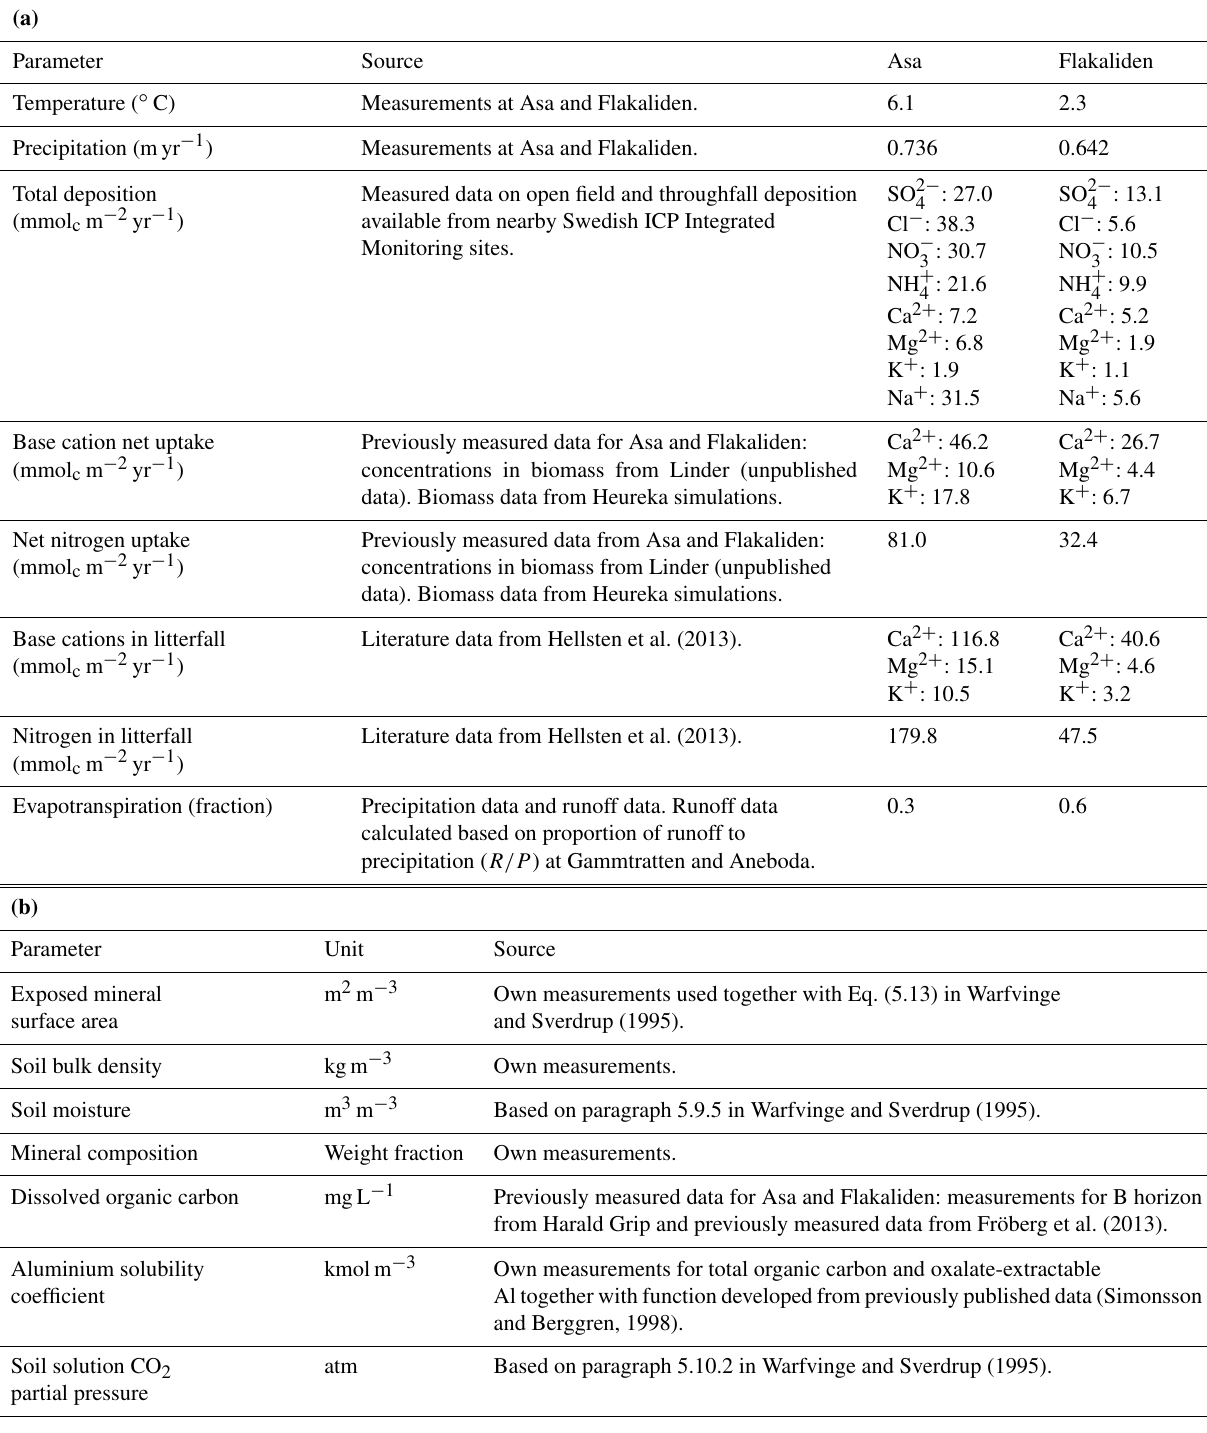
Table 4. (a) Site parameters used in the PROFILE model. (b) Soil ∗ parameters used in the PROFILE model. (a) Parameter Source Asa Flakaliden Measurements at Asa and Flakaliden. Measurements at Asa and Flakaliden. Measured data on open field and throughfall